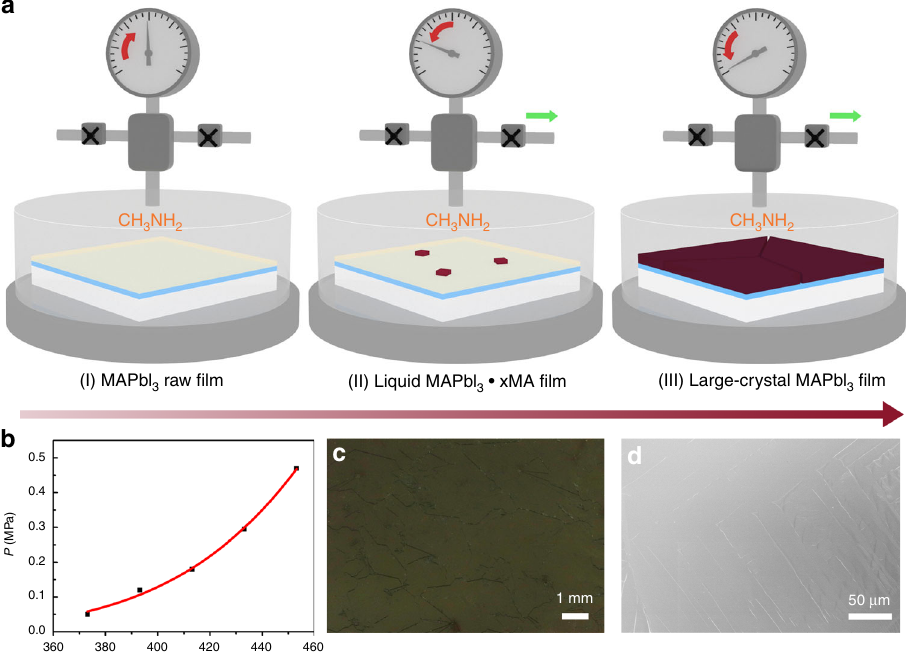
Fig. 1 Diagram of the methylamine gas-assisted crystallization method for the deposition of the large-grain MAPbI 3 perovskite fi lms. a The steps of the method: (I) formation of a liquid CH 3 NH 3 PbI 3 · x MA intermediate fi lm; (II) controlled growth of the nuclei; and (III) controlled growth of the perovskite fi lm. b Equilibrium partial pressure of the MA 0 gas as a function of temperature for the MAPbI 3 perovskite crystallization. c Photographic image and d top- view SEM image of the large-grain MAPbI 3 perovskite fi